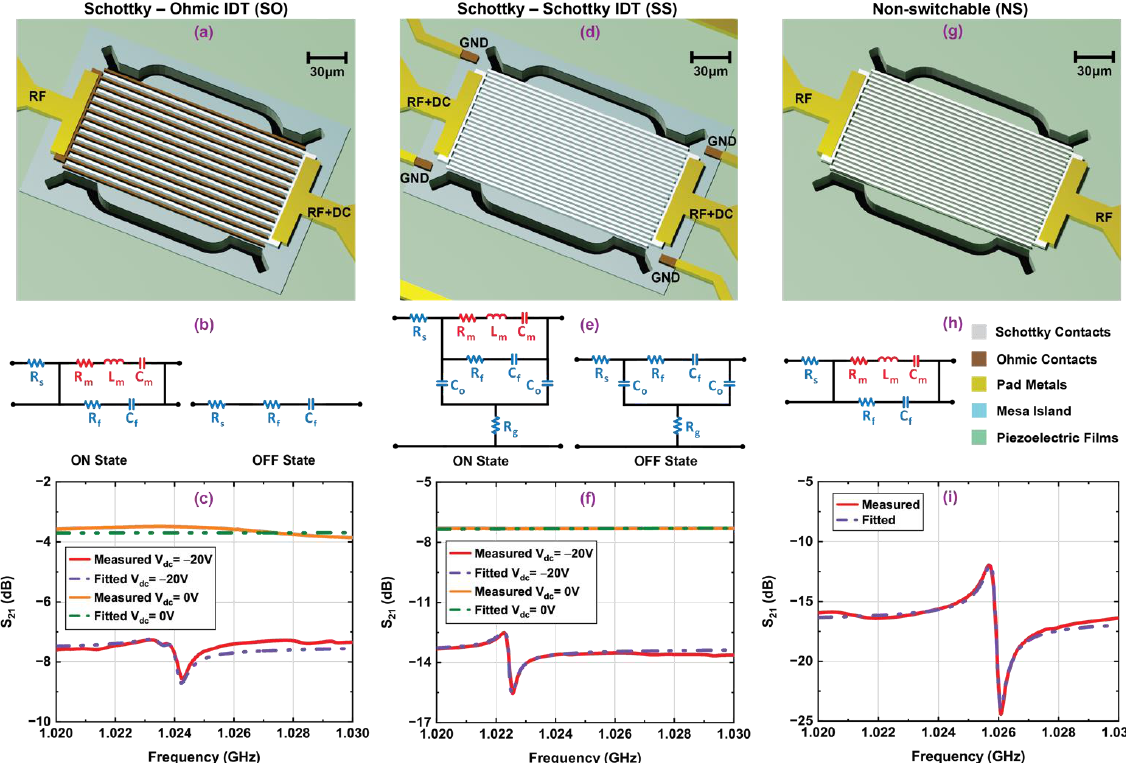
Figure 6. Three-dimensional schematic representation, equivalent circuit models, and measured frequency responses along with fitted curves for switchable transducers without control gates: ( a – c ) Schottky–Ohmic IDT (SO), ( d – f ) Schottky–Schottky IDT (SS), and ( g – i ) non-switchable (NS) transducers. All the resonators have IDT width and pitch 1.96 µm. The devices were measured under vacuum with −1 0 dBm input RF power. Table 2. Fitting parameters of the switchable transducers without control gate in ON/OFF states along with their non- switchable counterparts extracted from equivalent circuit models shown in Figure 6. Color coding coincides with the cir- cuits shown in Figure 6.